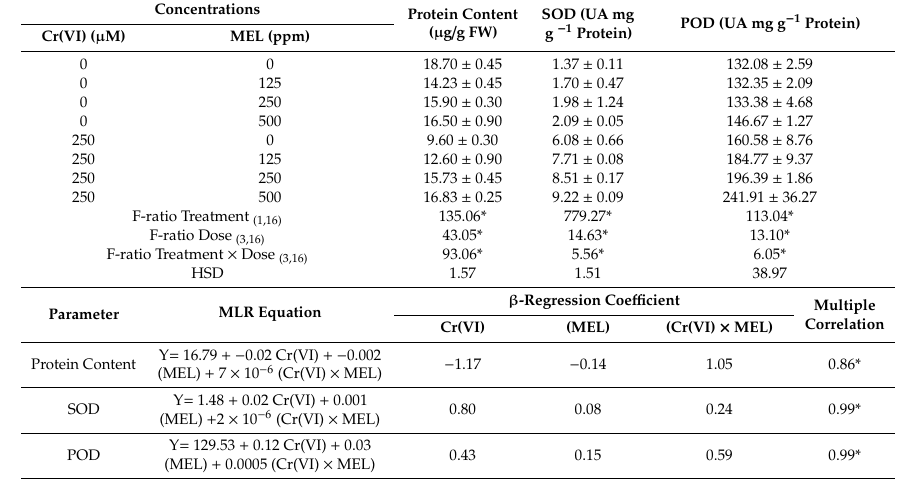
Table 3. E ff ect of Cr(VI), di ff erent concentrations of methanol extract of Rhododendron arboreum leaves (MEL), and their combinations on the protein content and activities of superoxide dismutase (SOD) and guaiacol peroxidase (POD) enzymes in 7-day-old Vigna radiata seedlings. The values are the means of three replicates ± S.D. (standard deviation). Tukeys test performed and significance checked at * p ≤ 0.05. The F ratio is the term in which ANOVA is represented; Cr(VI) = Dose, MEL treatments = Treatment and combination of Cr(VI) and MEL = Dose ×